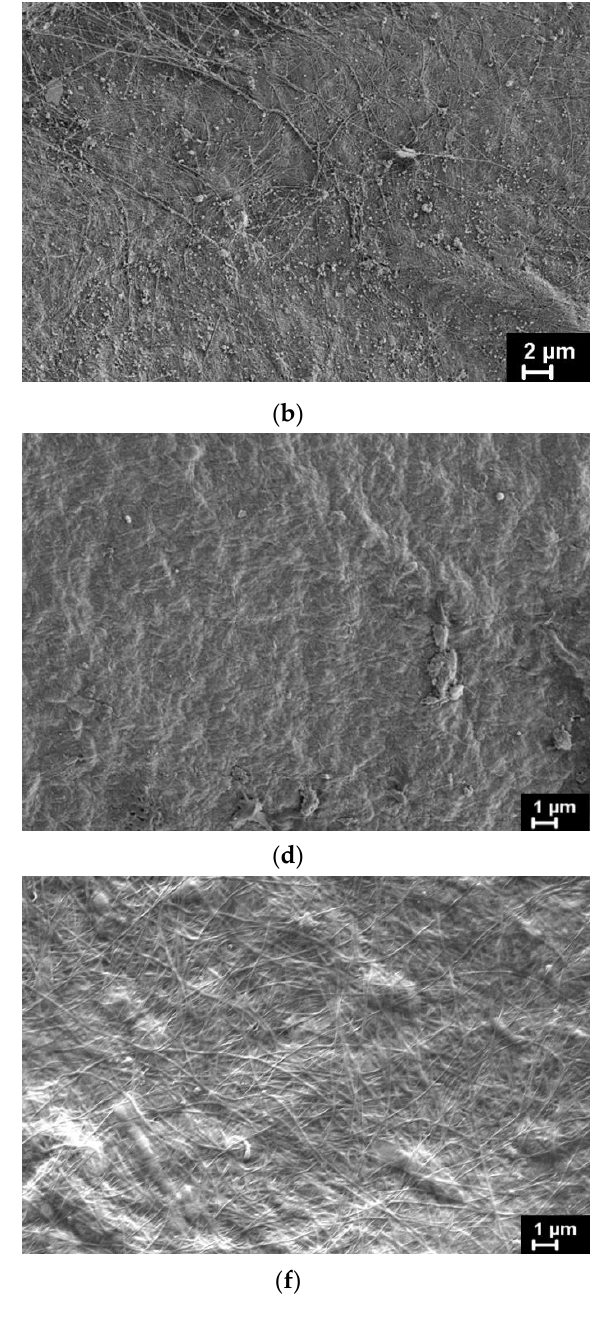
Figure 3. SEM images of BC film ( a , b ), BC – ALG – CS film ( c , d ), and BC – ALG(CeONP) – CS film ( e , f ): ( a , c , e ) — cryo-cleaved surfaces; ( b , d , f ) — film surfaces.